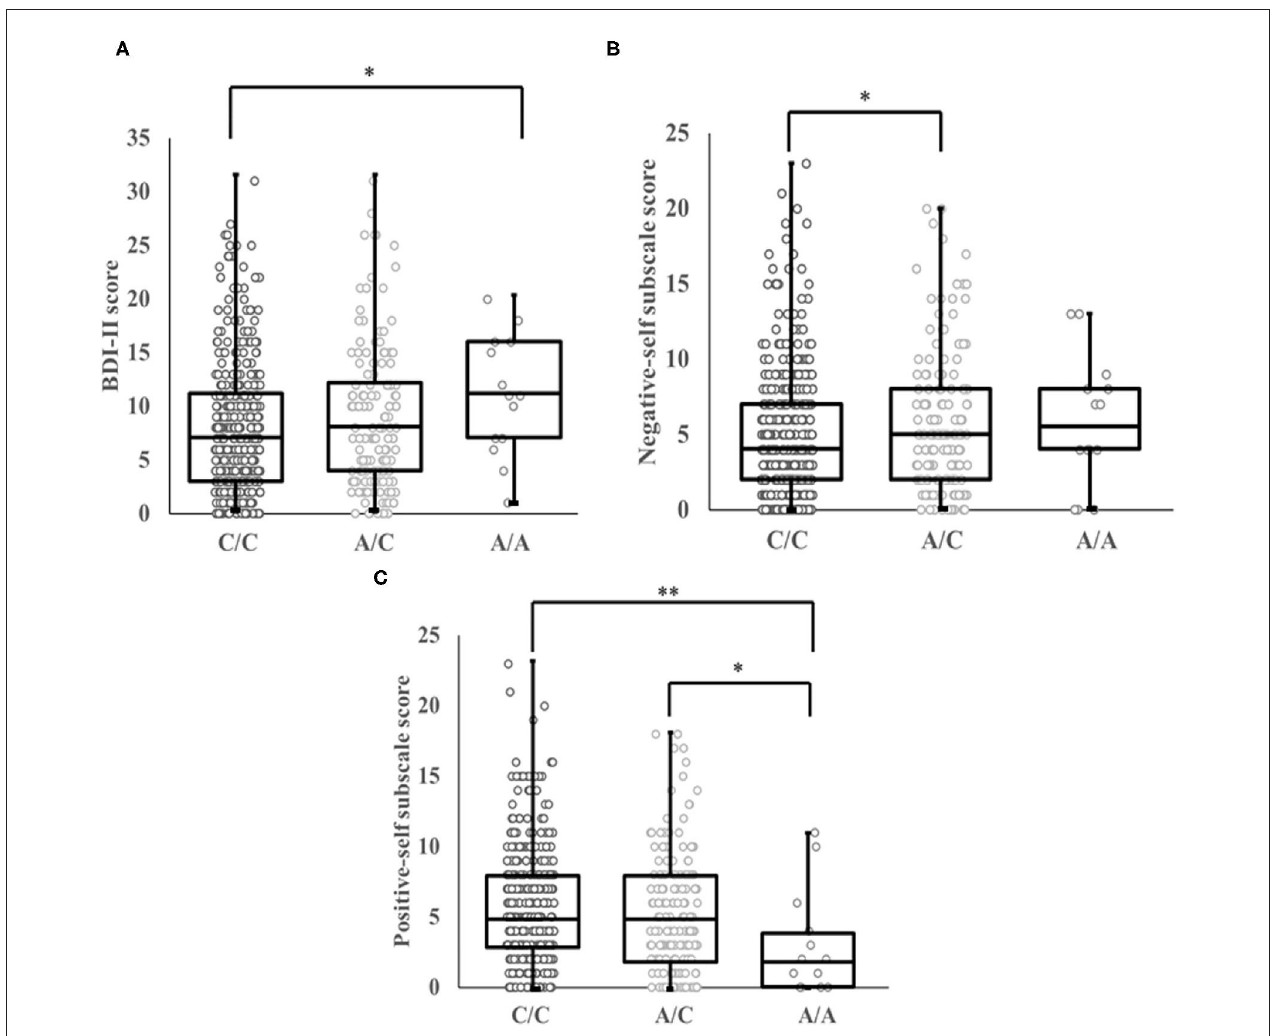
FIGURE 2 | (A) Association between genotype at SNP rs1059004 in the OLIG2 gene and BDI-II scores. There were significant correlations between A allele dosage and BDI-II scores among the three genotype groups. BDI-II scores decreased in a C-allele dose-dependent manner ( p = 0.022, Jonckheere-Terpstra test). AA genotype carriers had a significantly higher BDI-II score than the CC genotype carriers (Bonferroni-corrected p = 0.041). (B) Association between genotype at SNP rs1059004 in the OLIG2 gene and negative-self subscale scores. Significant gene-dose associations between the SNP rs1089004 and negative-self subscale scores were observed among the three genotype groups. Negative-self subscale scores decreased in a C-allele dose-dependent manner ( p = 0.012, Jonckheere-Terpstra test). Subjects with AC genotype had a significantly higher negative-self subscale score compared to those with CC genotype ( p = 0.026). (C) Association between genotype at SNP rs1059004 and positive-self subscale scores. The Jonckheere-Terpstra test also showed significant associations between A allele dosage and positive-self subscale scores among the three genotype groups. Positive-self subscale scores increased in a C-allele dose-dependent manner ( p = 0.037, Jonckheere-Terpstra test). People carrying the AA genotype had a significantly lower positive-self subscale score than those with the CC genotype and AC genotype, respectively (Bonferroni-corrected p = 0.009, p = 0.049). The bars of the box plot show the range from minimum scores to maximum scores. SNP,